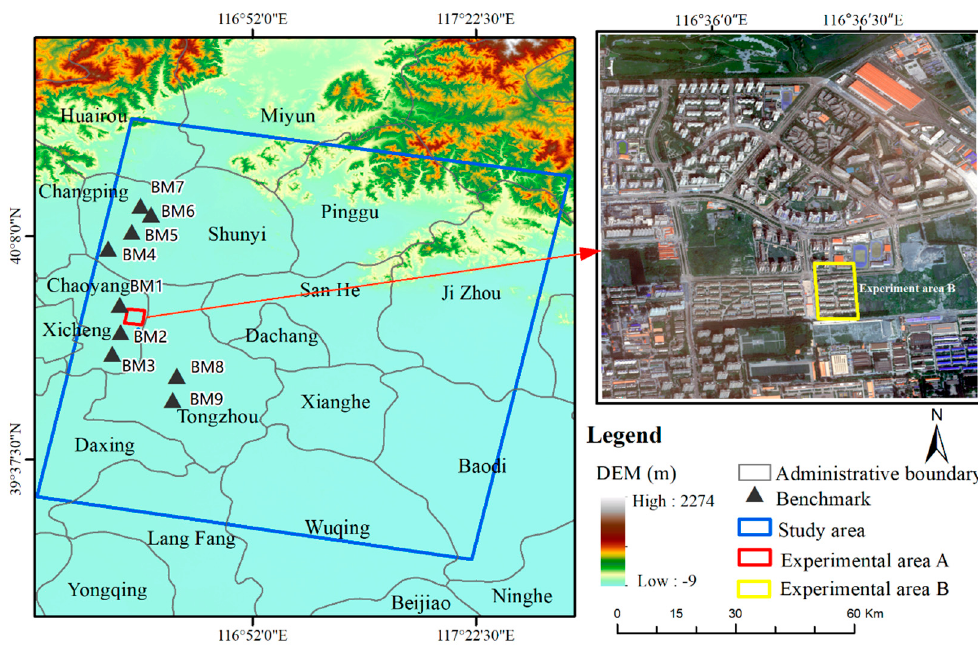
Figure 1. The geographical location of the study area. The blue box represents the range of study areas. The red box represents the experimental area A in Chaoyang CBD. The yellow box indicates the locations of the experimental area B with dense buildings in Chaoyang CBD. The black triangles are the position of the benchmarks.